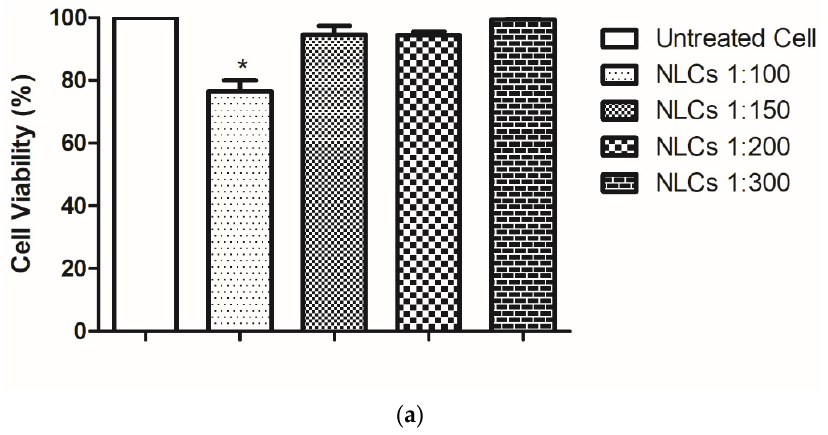
Figure 8. Cytotoxicity on Caco-2 cell line (% vs. untreated cells) of ( a ) NLCs and ( b ) K-NLCs at different dilutions (1:100, 1:150, 1:200, and 1:300) after 3 h of exposure. Data are shown as mean ± standard error ( n = 3). * = p <